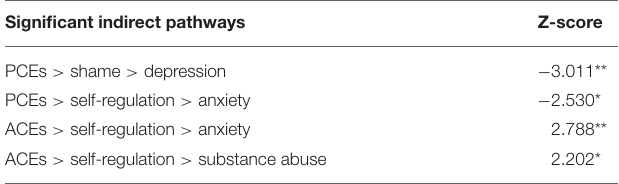
TABLE 3 | Results of significant paths for shame and self-regulation as